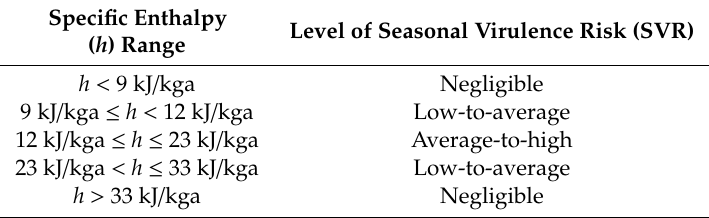
Table 2. Proposed h-related risk